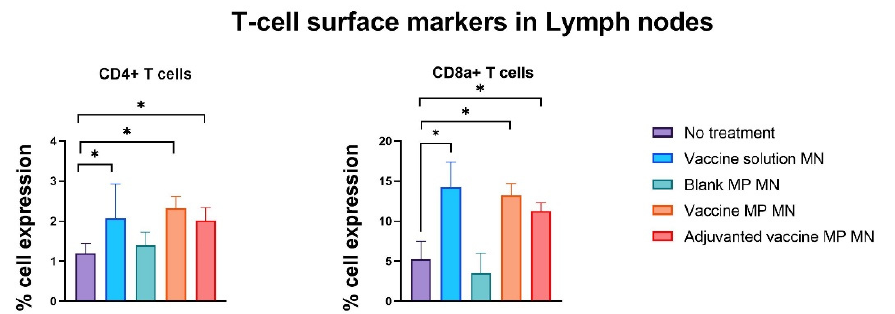
Figure 8. Assessment of T-cell surface markers in lymph nodes of immunized mice using flow cytometry. Mice were immunized via transdermal route with one prime dose on day 0 and two booster doses on days 15 and 29. Seven days post-challenge with live Zika virus, mice were sacrificed, and the lymph nodes were extracted, processed into single-cell suspensions, and analyzed for the presence of T-cell surface markers. Samples from mice receiving vaccine solution, vaccine MPs, and adjuvanted vaccine MPs showed significantly higher expressions of CD4 and CD8a cell surface markers than the control group (data presented as mean ± SEM, n = 5, One-Way ANOVA test followed by Dunnett’s multiple comparison test; *, p < 0.05).